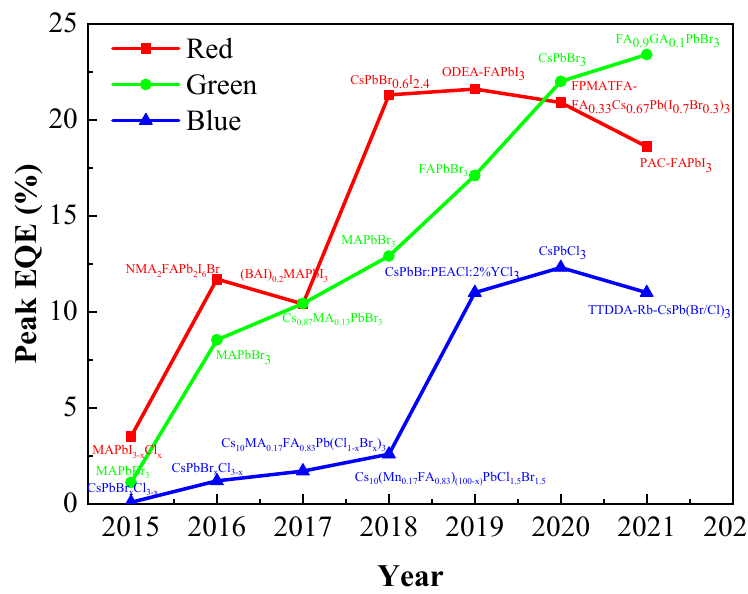
Figure 12. Evolution curve of the peak EQE of perovskite QLED.